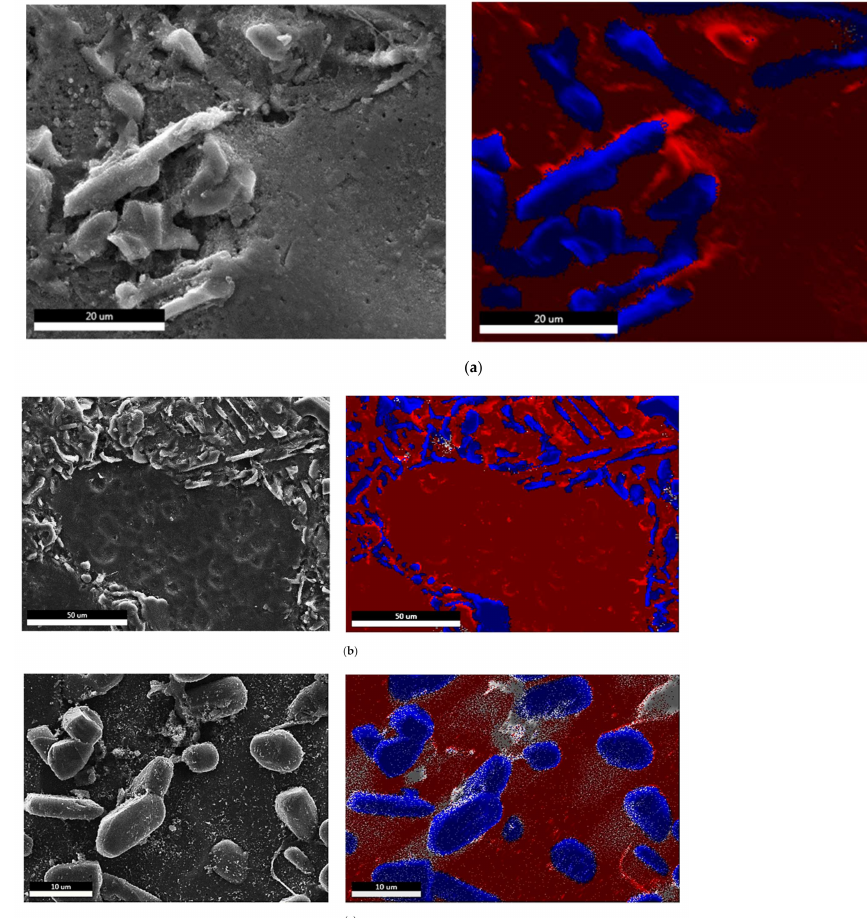
Figure 11. Electron images of deeply etched alloy samples showing element distribution (blue: Si particles, red background: Al matrix) in: ( a ) un-modified alloy—as cast, ( b ) Sr-modified alloy—as cast, ( c ) Sr-modified alloy—T6